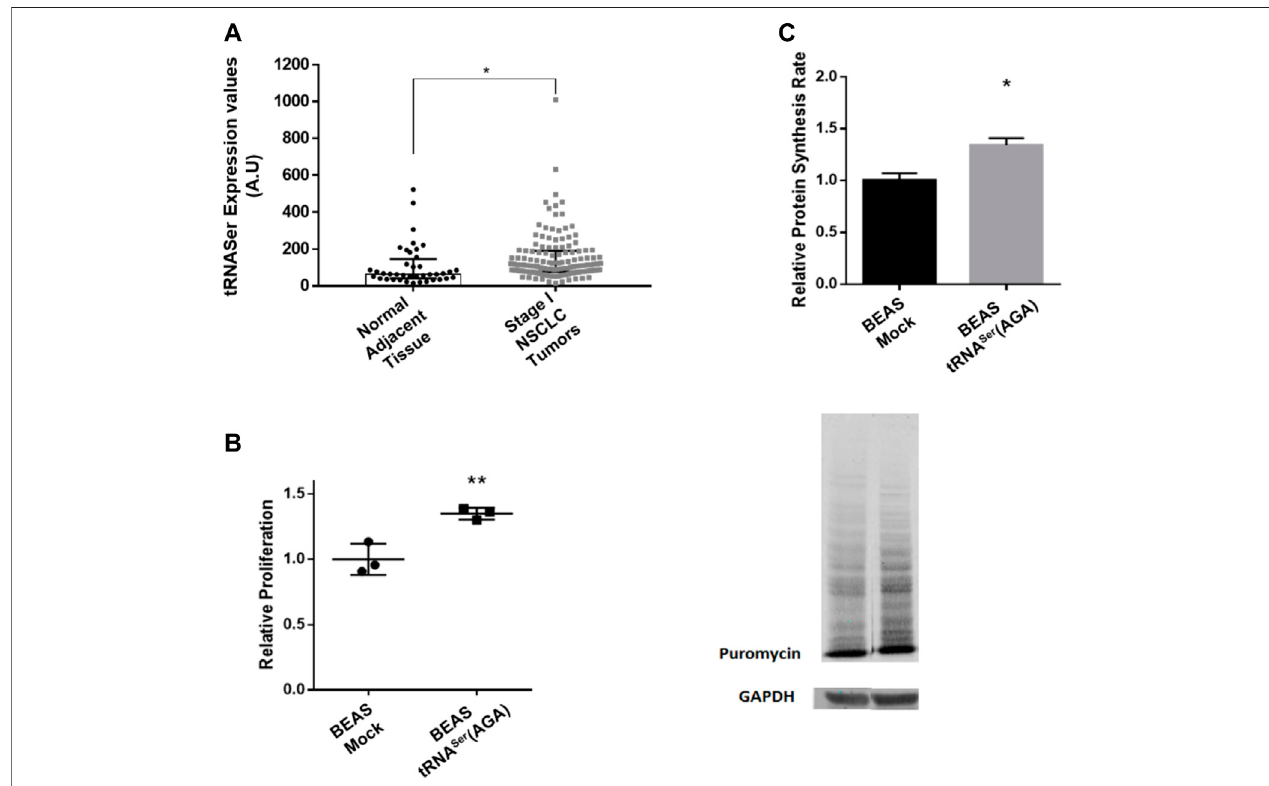
FIGURE 1 | Overexpression of tRNA Ser increases cell proliferation and protein synthesis rate. (A) tRNA-Ser-AGA-2-1 expression levels are increased in Stage I tumors when compared to normal adjacent tissue. Data was analyzed with Student ’ s t-test and signi fi cant p values is shown (* p < 0.05) (B) To evaluate cellular proliferation, 5 × 10 3 cells/well were plated in 96-well plates and incubated for 48 h prior to measuring BrdU incorporation during DNA synthesis, using a colorimetric immunoassay.RelativeproliferationofBEAS-2Bderivedcelllines – TheoverexpressionoftRNA Ser increasedcellularproliferationcapacity invitro. (C) tRNA Ser (AGA) upregulation increased protein synthesis rate in normal lung cell lines. Protein synthesis rate was estimated by immunoblot against puromycin. GAPDH served as a protein loading control. Graphics depict average ± SEM of n = 3, with three technical replicates. Data was analyzed with One-way ANOVA and Holm Sidak ’ s post-test and signi fi cant p values are shown (* p < 0.05; ** p <